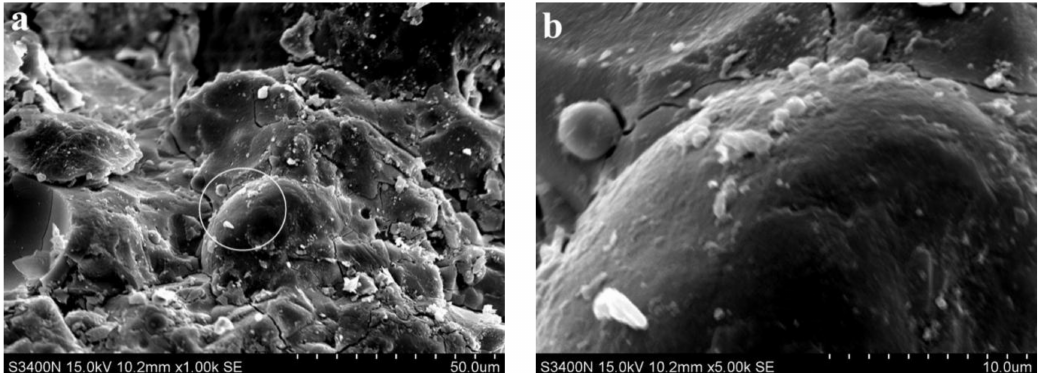
Figure 11. SEM images of alkali slag cement sand substituted with 50% fly ash at hydration ages of 28 d. ( a ) × 1.00 k, ( b ) × 5.00